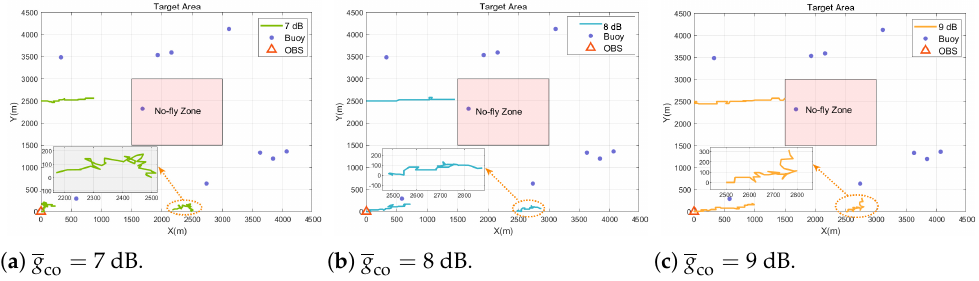
Figure 7. UAV trajectories with different SNR thresholds.